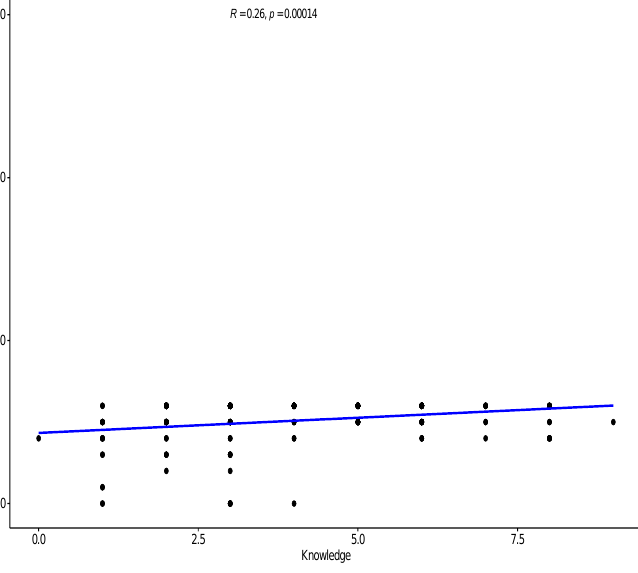
Figure 1. Scatter plot with regression line to show the correlation between knowledge and attitude. There is a statistically significant positive weak correlation between knowledge and attitude (R = 0.26).